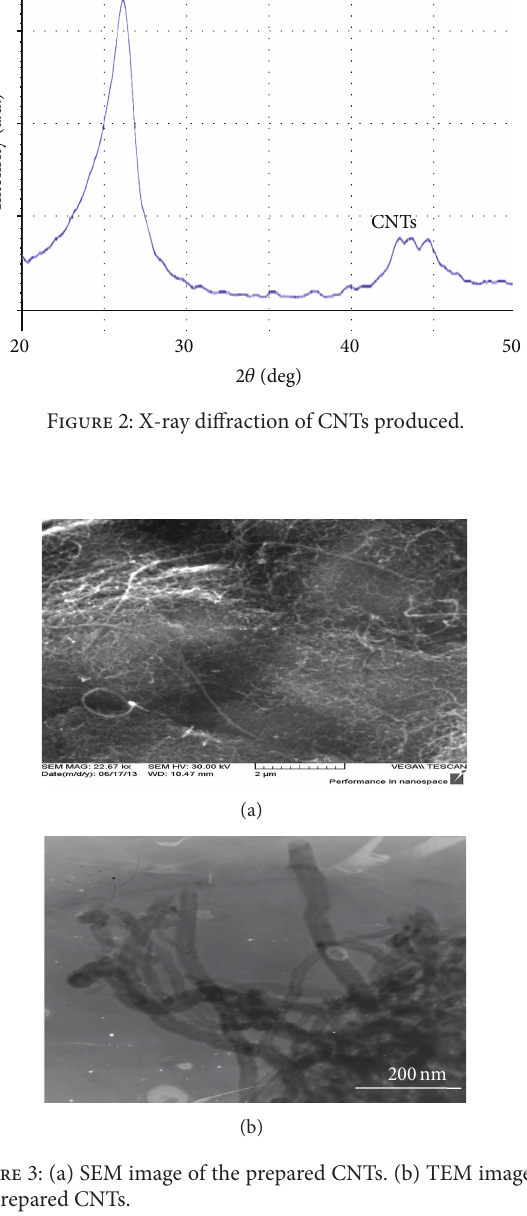
Figure 5: Dispersibility behavior of (a) as-prepared and (b) modi- fied